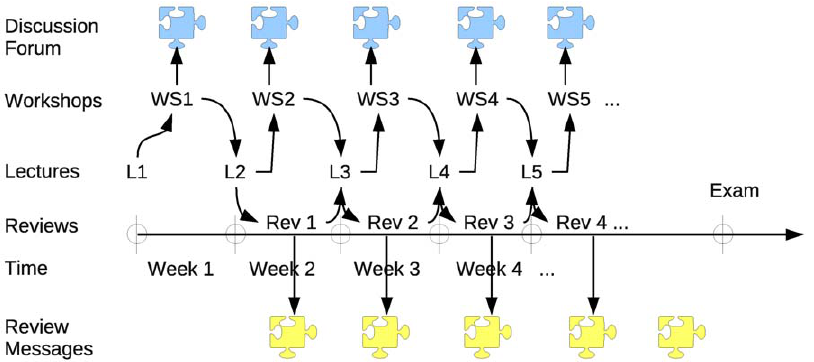
Figure 1. Schedule of learning activities.